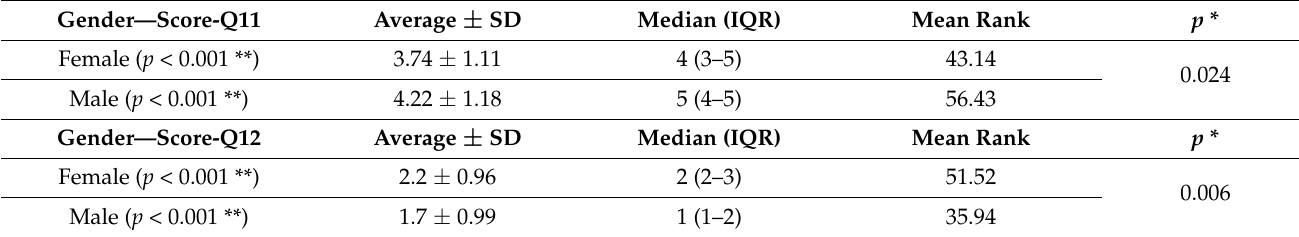
Table 3. Comparison of Score-Q11 and Score-Q12 according to gender.